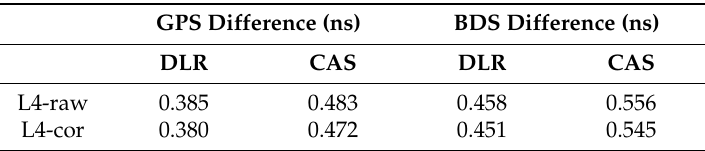
Table 2. RMS of GPS and BDS DCB differences between the FY3C-based results and the DLR and CAS